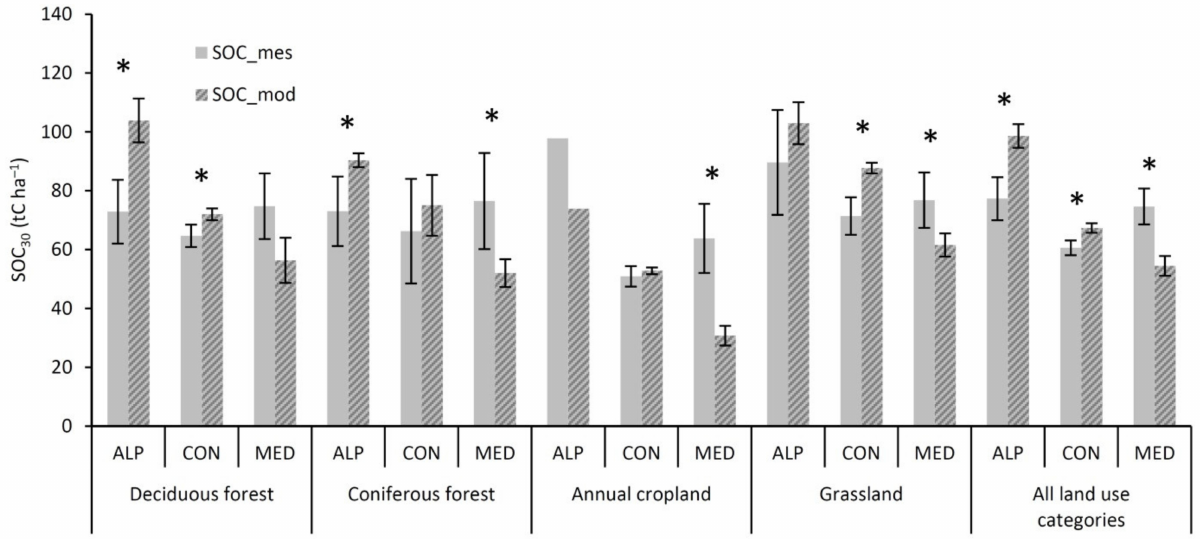
Figure A1. Comparison of measured and modelled soil organic carbon stocks down to 30 cm in different land-use categories with respect to biogeographical regions. Asterisk indicates statistically significant difference ( p < 0.01) between measured and modelled data at the land use × biogeographical region